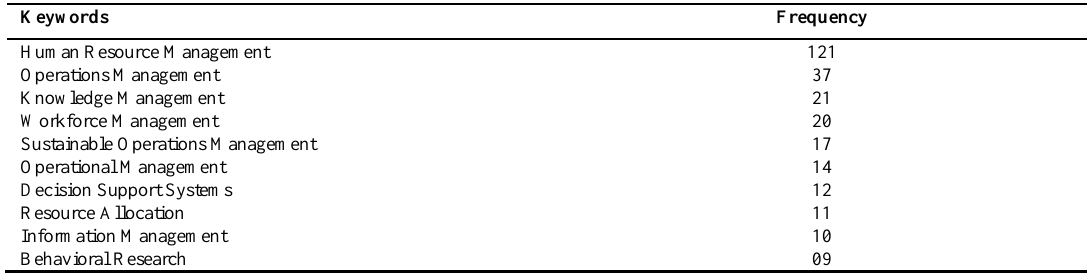
Table 9. Top 10 keywords: intellectual capital and operational excellence